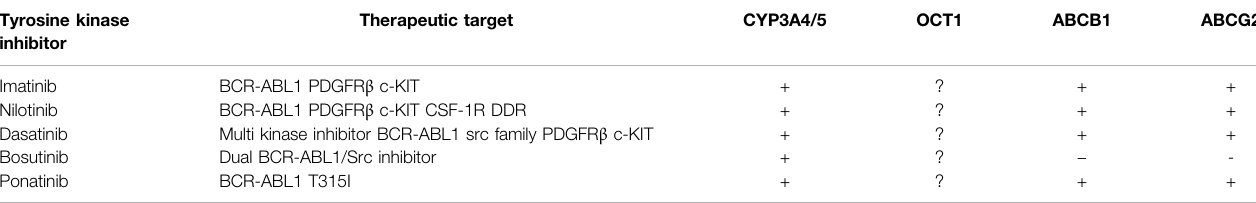
TABLE 1 | Therapeutic targets, impact of metabolic pathways and drug transporters of tyrosine kinase inhibitors, used for the treatment of CML. Tyrosine kinase